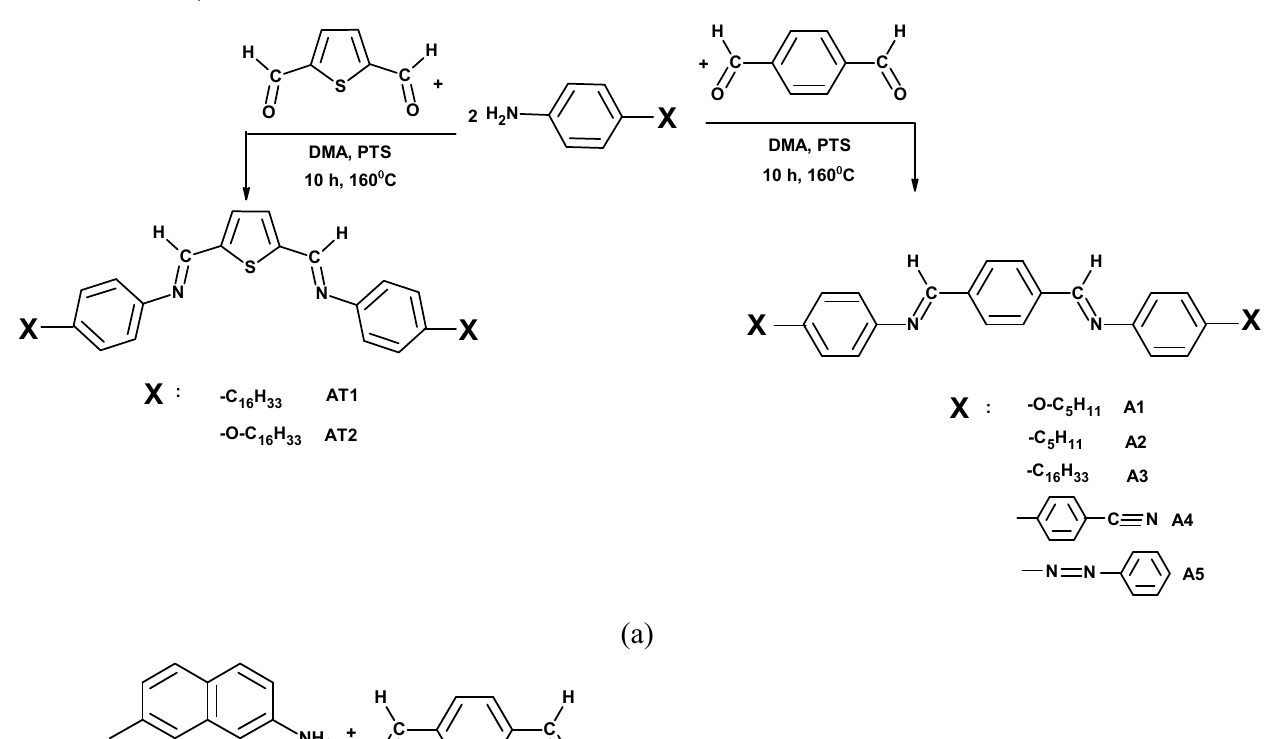
Figure 1. ( a) Synthetic route to the symmetrical azomethines. (b) Synthetic route to the unsymmetrical azomethines. (c) Geometry optimization of A3 (right) and AT1 (left, side